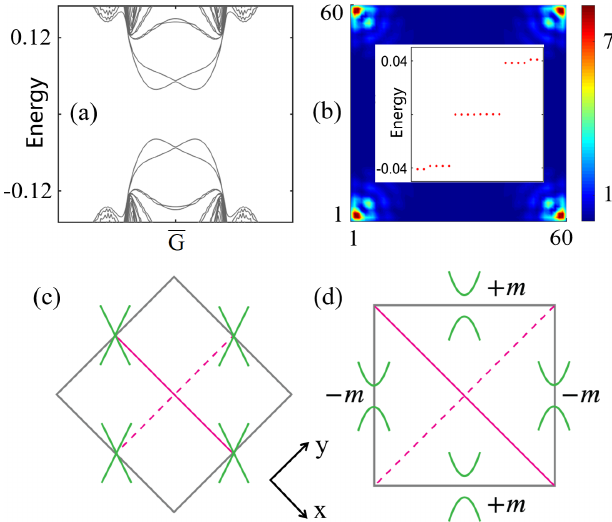
FIG. 4. (a) shows the edge modes on the (11) boundary in the same condition as those in Fig. 3(a). (b) shows the wave-function profiles of the zero-energy modes in the real space under open- 1¯1 boundary conditions in both the ½ 11 (cid:3) and ½ (cid:3) directions, with the low-energy spectrum presented in the inset. The color bar in (b) is in the unit of 10 − 3 . The origin of the corner Majorana modes is sketched in (c) and (d). The magenta (dashed) line labels the 0 g ( f M 0 g ). (c) shows the Dirac cones on mirror symmetry f M y j x j 0 g = f M 0 g . Notice that we the ð 10 Þ = ð 01 Þ edge protected by f M y j x j use the green lines to label the two Dirac cones on each edge for simplicity. When the edges evolve into the condition in (d), i.e., 1¯1 the (11) and ð Þ boundaries, on each edge the mirror symmetry no longer preserves and the Dirac cones gain a mass term. The mass terms on different edges are odd with respect to the mirror 0 g and f M 0 g and form the configuration in symmetries f M y j x j (d). At the corners, the sign-changed mass terms lead to the zero- energy